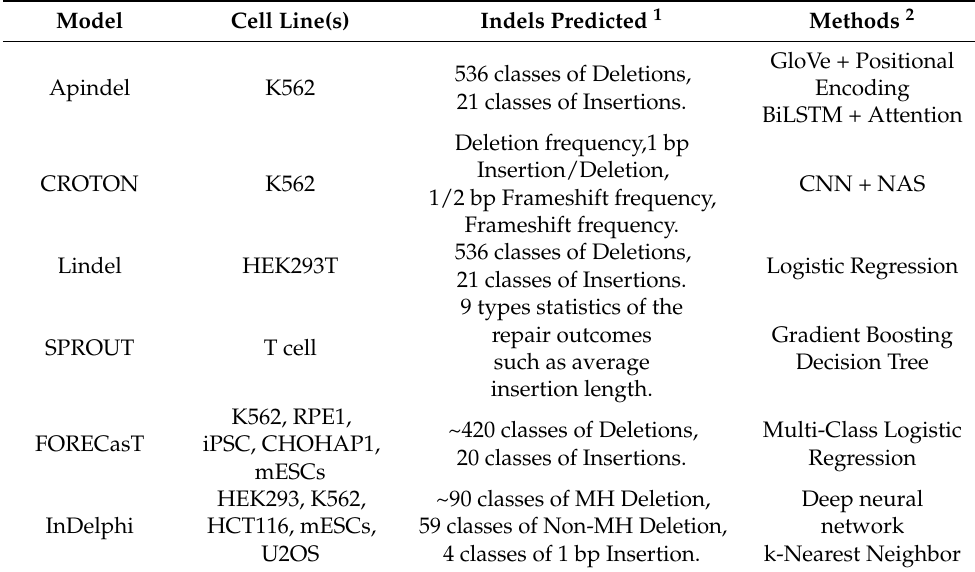
Table 1. Comparison of designs and results of CRISPR/Cas9 editing outcome prediction.